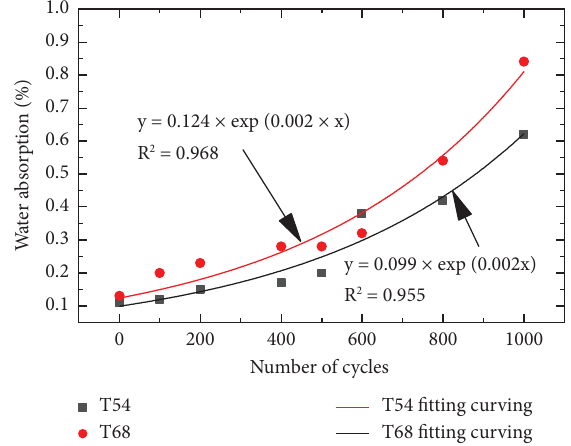
Figure 12: Water absorption vs. number of cycles.